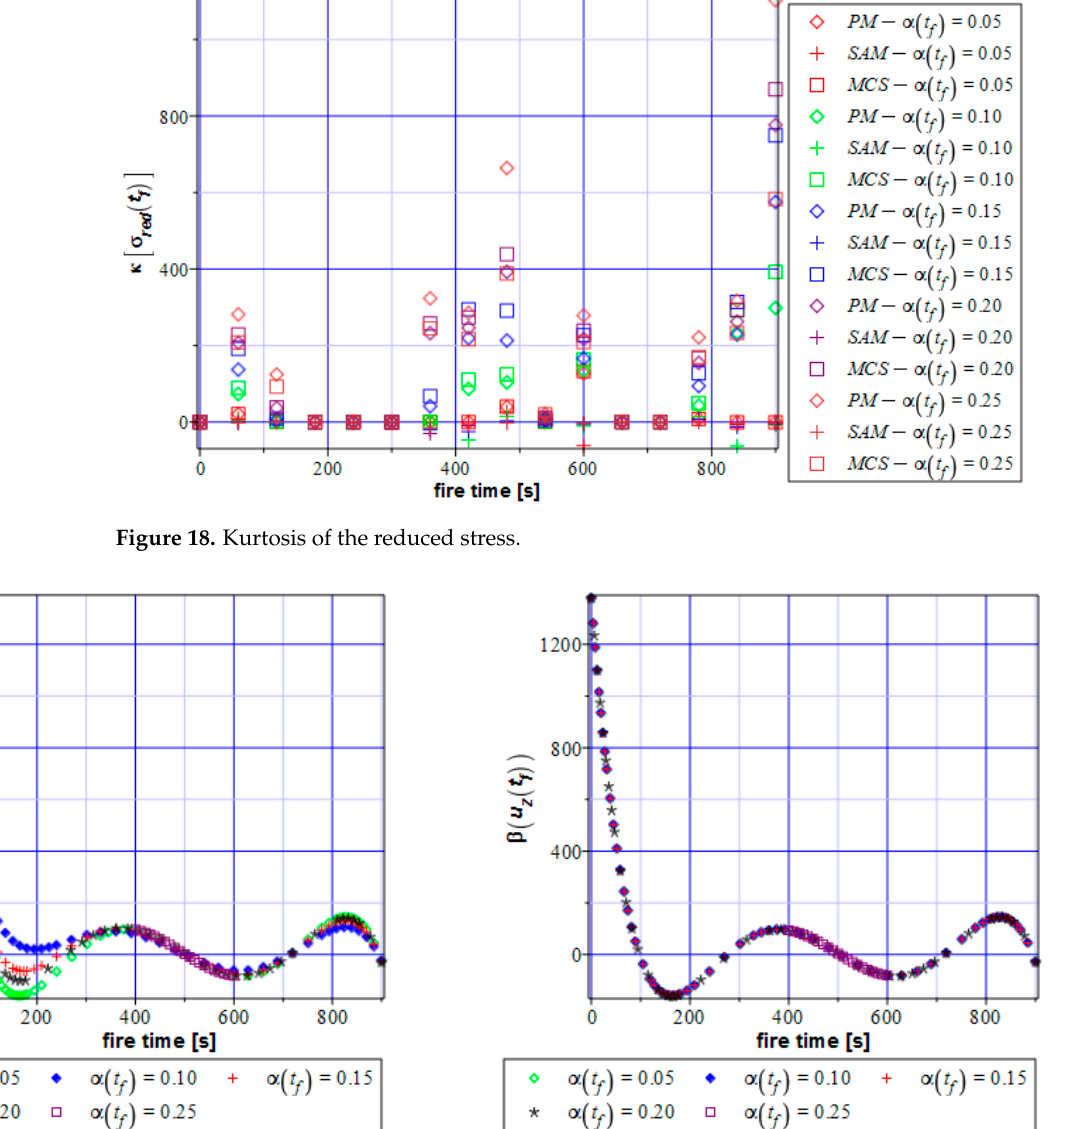
Figure 19. Reliability index for the vertical displacements as a function of fire duration according to